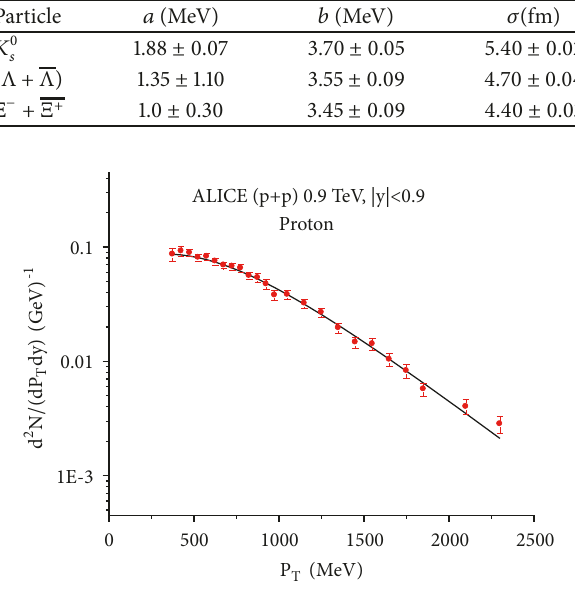
Figure 2: Transverse momentum spectrum of protons